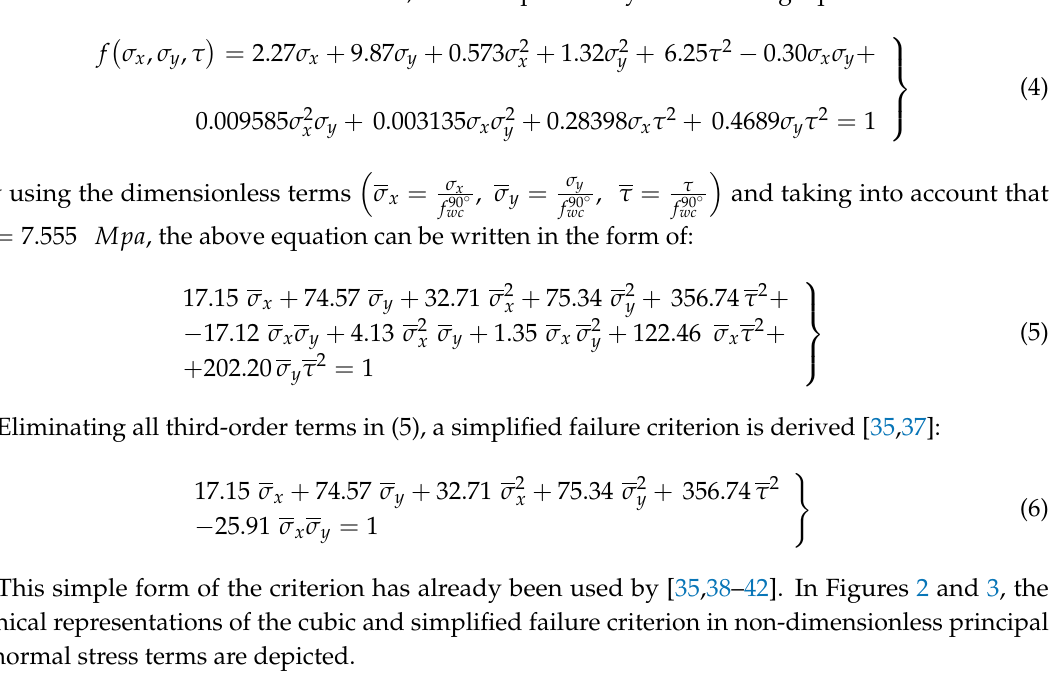
( b ) Figure 3. Non-dimensionless failure surface of masonry material using the simplified failure criterion: ( a ) non-dimensionless normal stress terms; ( b ) non-dimensionless principal stress terms. Table 1. Minima and maxima for both failure criteria/surfaces. Criteria